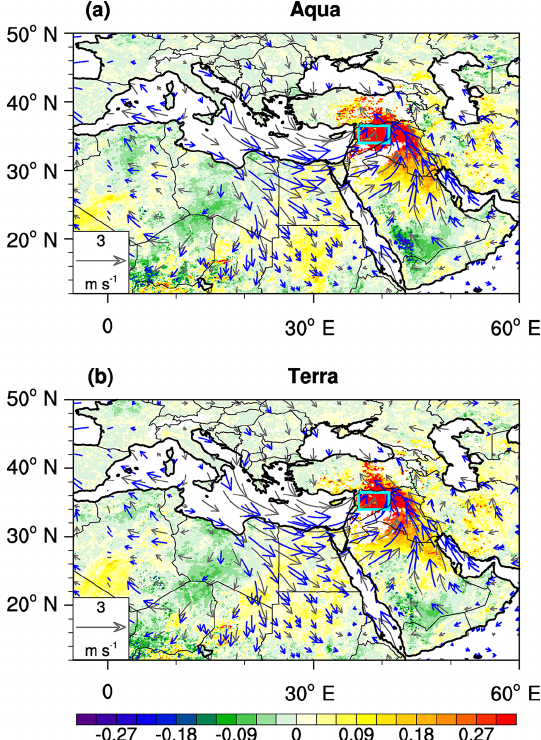
Figure 10. Composites of (a) Aqua and (b) Terra daily DOD (shad- ing) along with ERA-Interim 10m horizontal wind anomalies (with reference to the 1979–2015 mean; vectors) for days with Syrian DOD index (Aqua) greater than 1 standard deviation during MAM from 2003 to 2015. Shading shows values significant at the 95% confidence level over land, while wind vectors significant at the 95% confidence are plotted in blue ( t